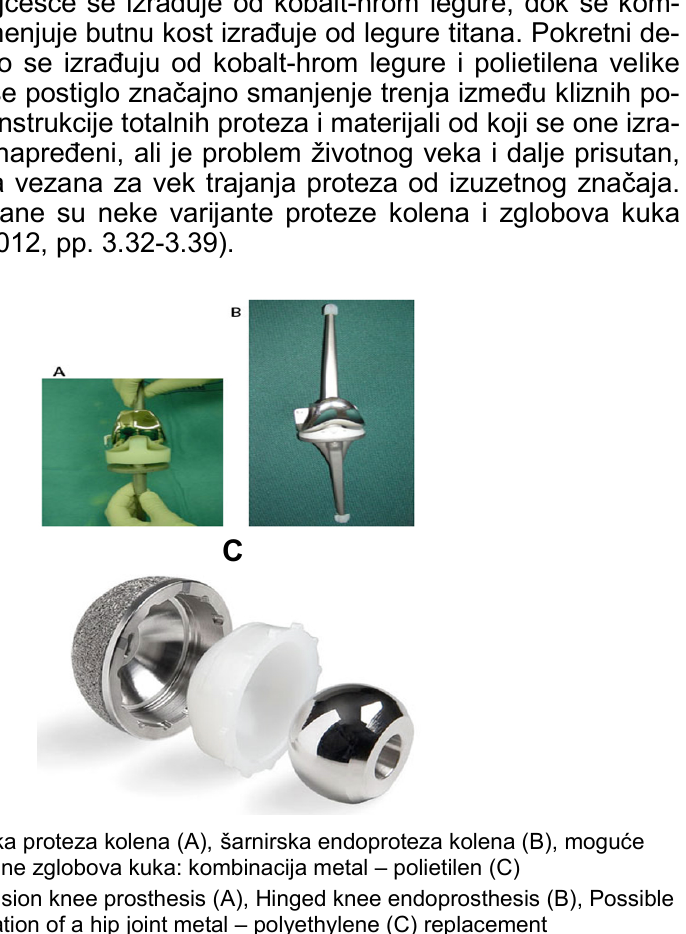
Figure 2 – Revision knee prosthesis (A), Hinged knee endoprosthesis (B), Possible combination of a hip joint metal – polyethylene (C)